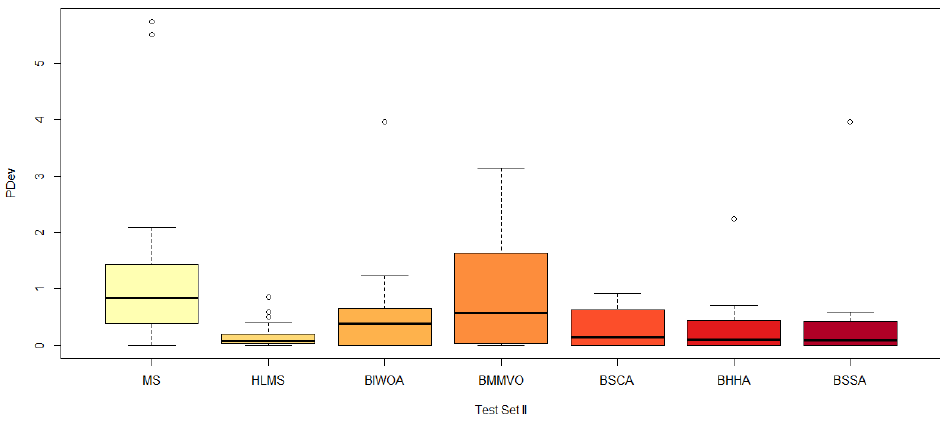
Figure 3. Boxplot for 7 comparative algorithms on PDev for Test set II.